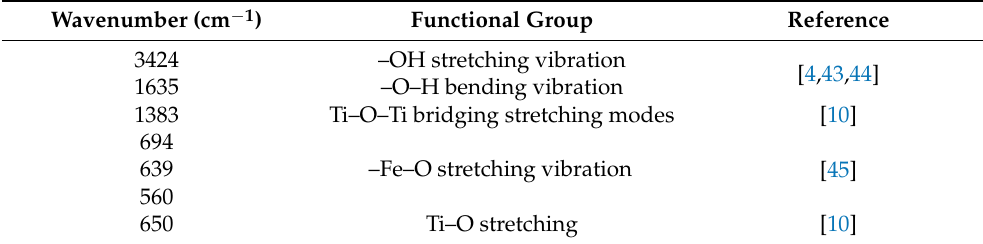
Table 2. Functional group present in FTIR spectra of Fe 3 O 4 , TiO 2 , and TiO 2 –Fe 3 O 4 .